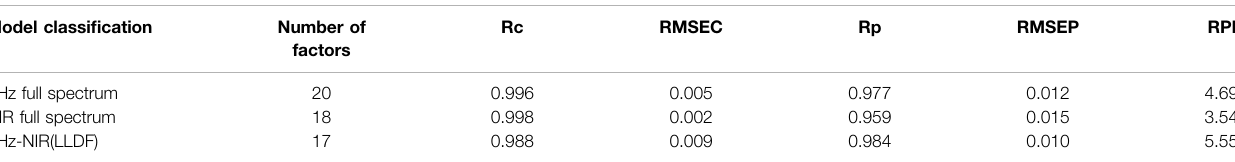
TABLE 2 | Results of PLS model